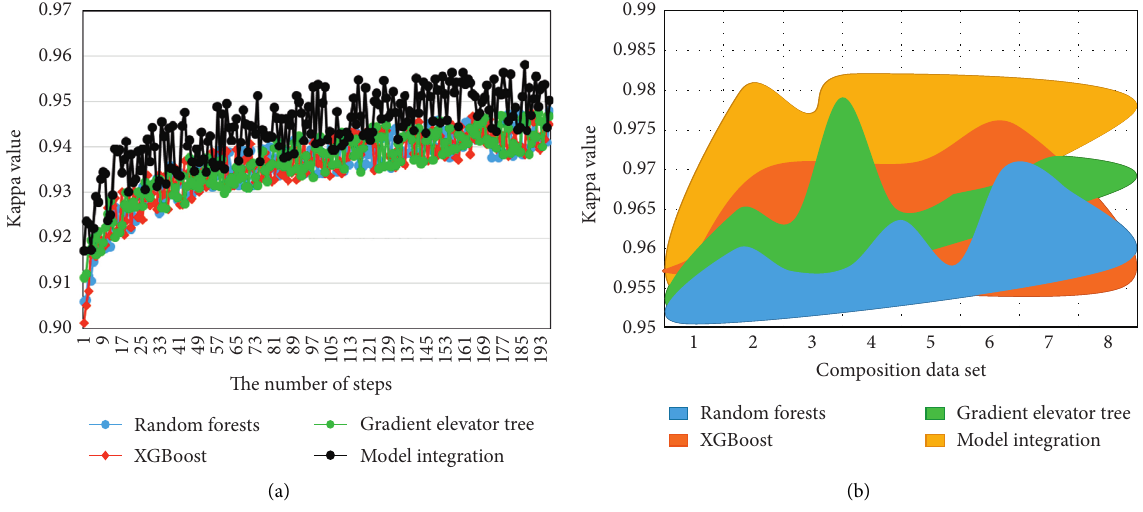
Figure 9: Results of nontext features in each essay set. (a) In all composition data sets. (b) In different composition data